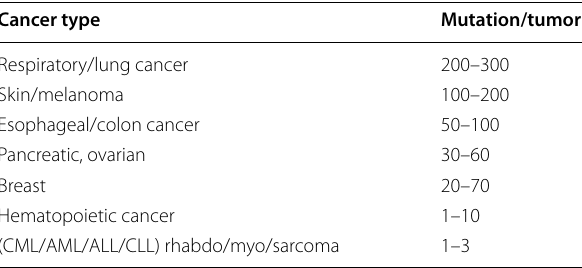
Mutations of tumor cells were based on means of mutation in single patients (CML/AML/ALL/CLL) Soft